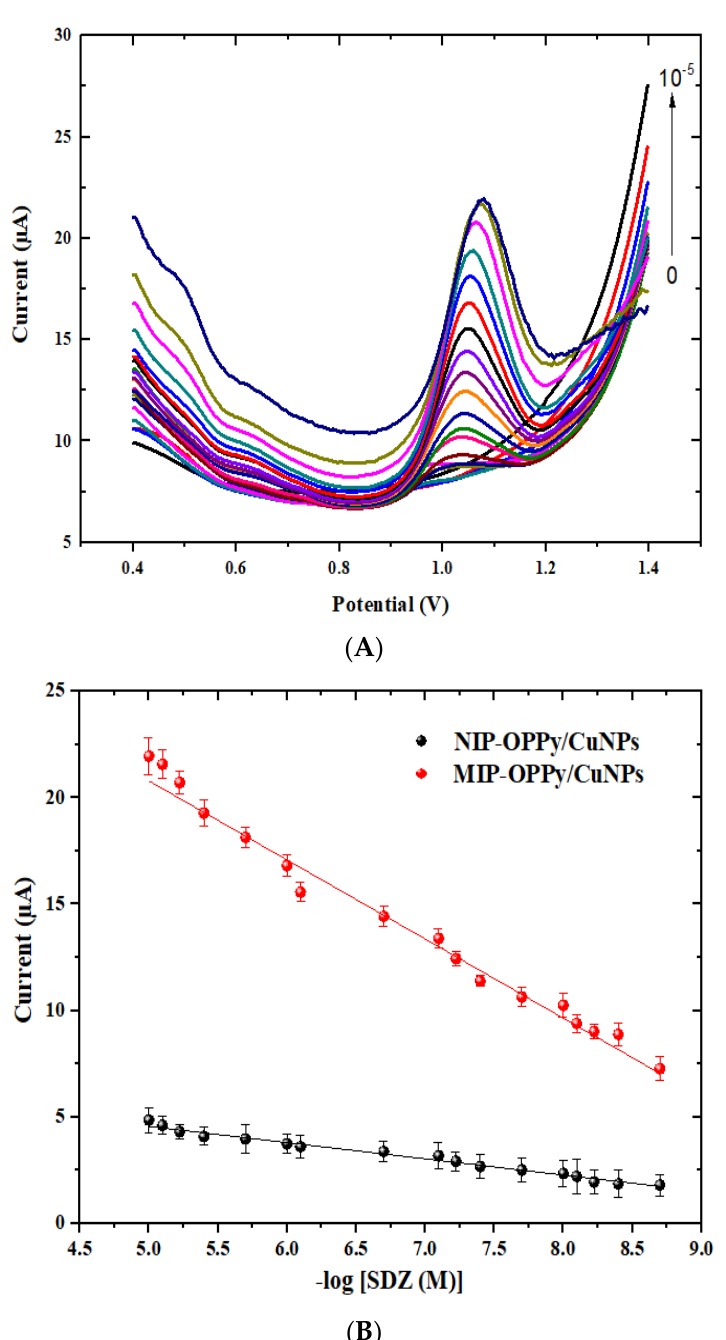
Figure 12. ( A ) DPV response of the MIP sensor for concentrations of SDZ (10 − 9 –10 − 5 mol L − 1 ) in H 2 SO 4 solution (pH 2), ( B ) the corresponding calibration curves for MIP and NIP sensors: DPV peak current versus the − logarithm of SDZ concentration. Table 2. Analytical performance of previously published electrochemical sensors for SDZ detection.